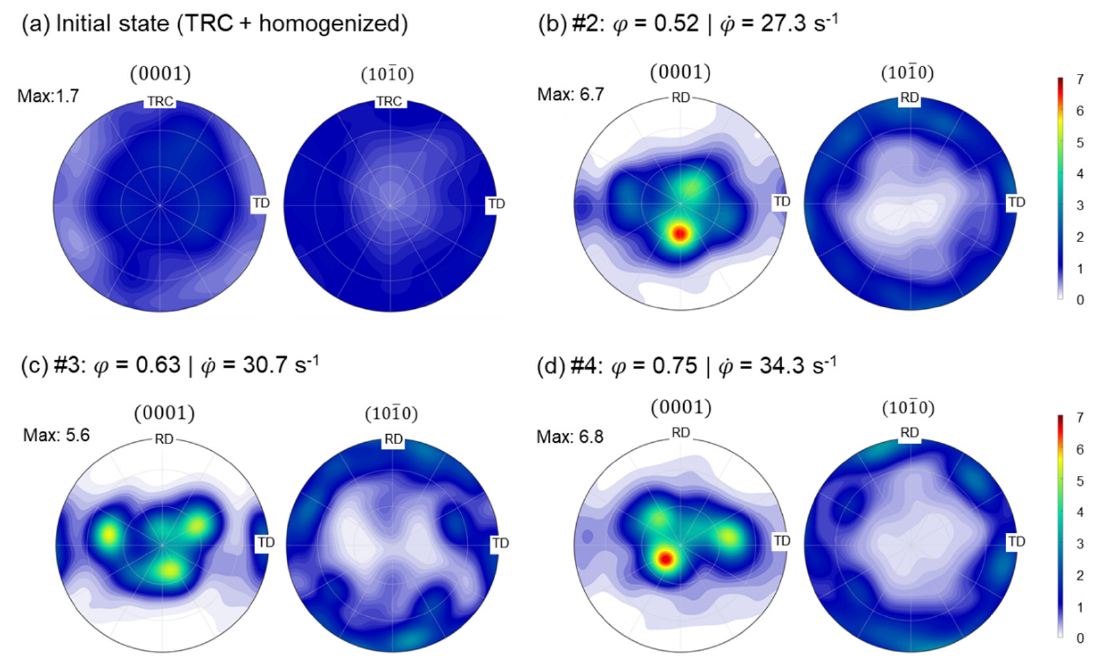
Figure 6. (0001) and (10 1(cid:3364) 0) pole figures of ( a ) the initial state, ( b ) sample #2, ( c ) sample #3, and ( d ) sample #4 .